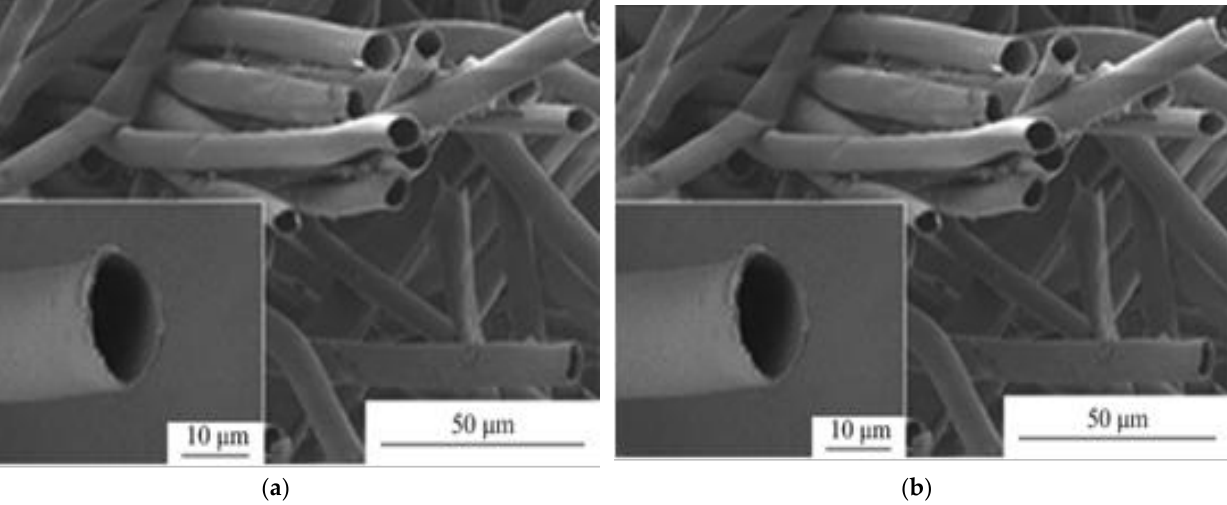
Figure 1. SEM image of ( a ) kapok fibers [47]. Reprinted by permission from Springer Nature Customer Service Centre GmbH: Springer Nature, Chinese Journal of Polymer Science, Investigation on sound absorption properties of kapok fibers, Xiang, H.F., Wang, D., Liua, H.C., Zhao, N., & Xu, J., Copyright (2013). SEM image of ( b ) cross section of kapok fibers [46]. Reprinted from Industrial Crops and Products, 61, Dong, T., Wang, F., & Xu, G., Theoretical and experimental study on the oil sorption behavior of kapok assemblies, 325–330, Copyright (2014), with permission from Elsevier.